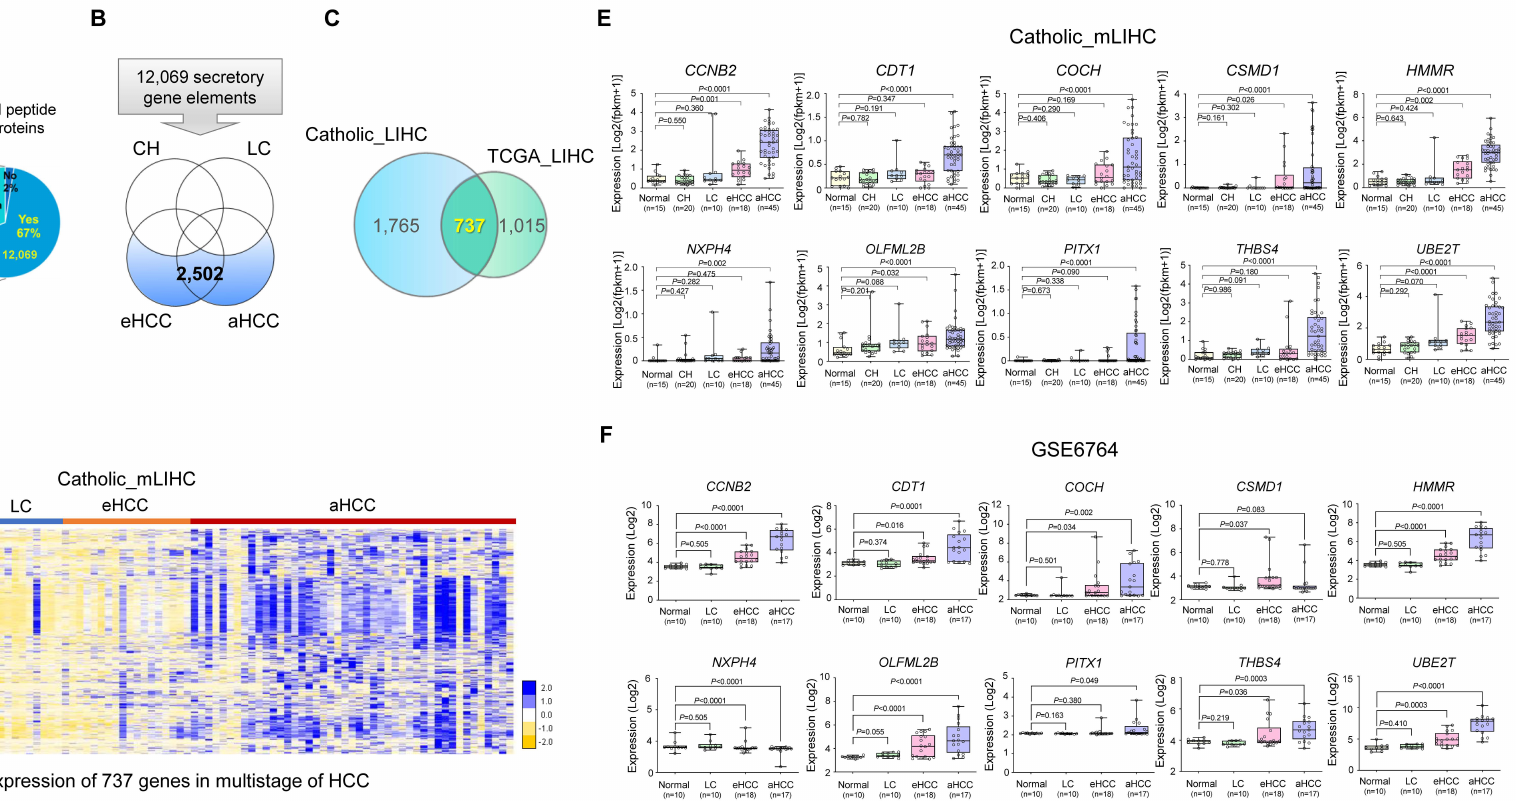
Figure 2. Liver transcriptome scans of characteristic molecular signature in healthy controls and patients with liver disease. ( A ) Pie chart analysis according to gene types and signal peptides of protein coding genes. ( B ) Venn diagram analysis showing genes overexpressed in the early-stage HCC and advanced HCC groups, but not overexpressed in the chronic hepatitis and liver cirrhosis groups. ( C ) Venn diagram analysis of selected genes in (B) from two different RNA-Seq datasets (Catholic_LIHC and TCGA_LIHC). ( D ) Heatmap analysis of 737 HCC-associated gene signatures in Catholic_mLIHC. ( E , F ) Expression changes of 10 candidate marker genes in multistage liver disease patients of ( E ) Catholic_mLIHC (cohort 1, n = 108) and ( F ) GSE6764 ( n = 55). Statistically significant differences were determined using Welch’s t